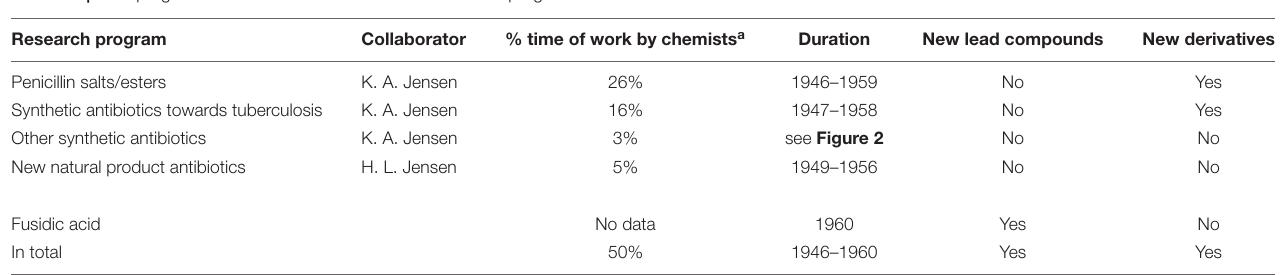
TABLE 2 | Main programs and collaborators in antibiotic research programs at LEO